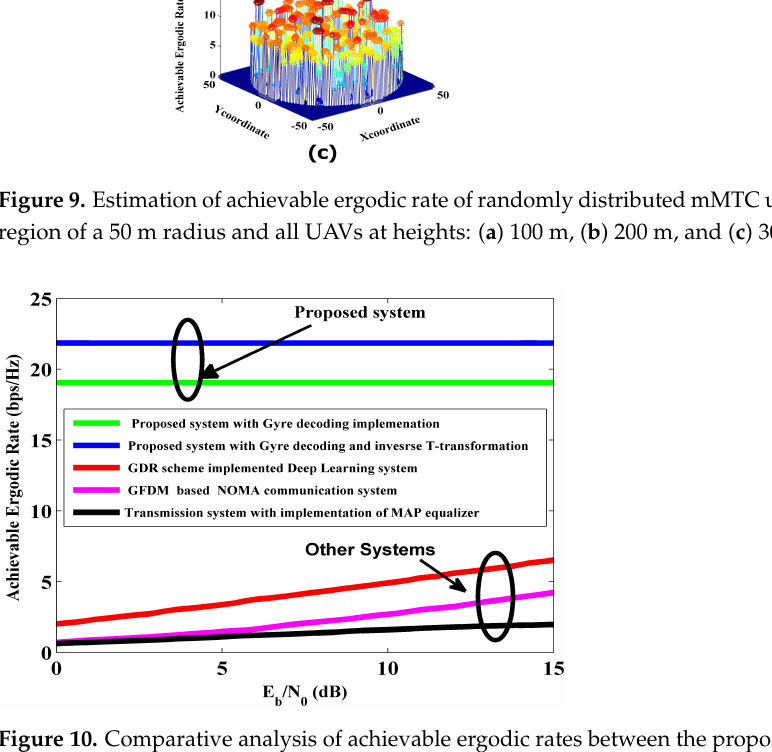
Figure 10. Comparative analysis of achievable ergodic rates between the proposed system and other similar communication systems.